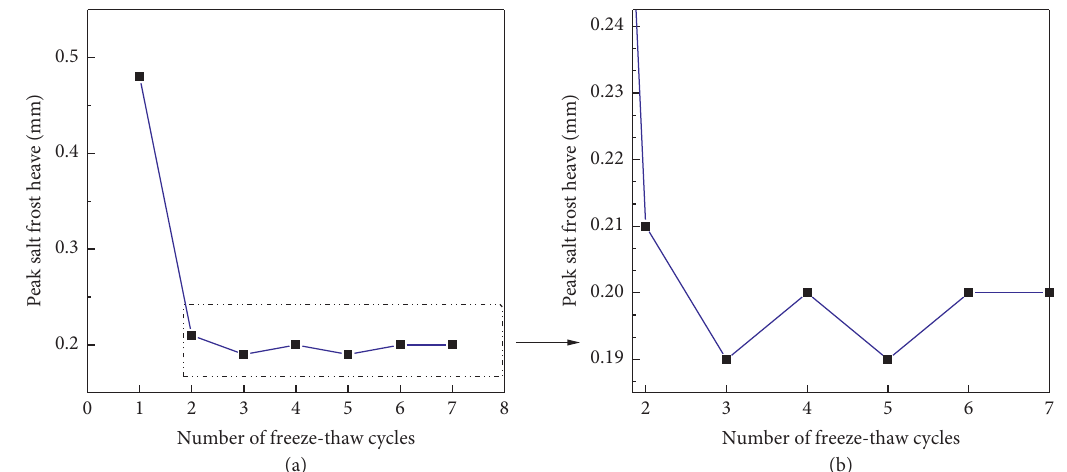
Figure 11: Relationship between peak salt-frost heave and number of freezing-thawing cycles.